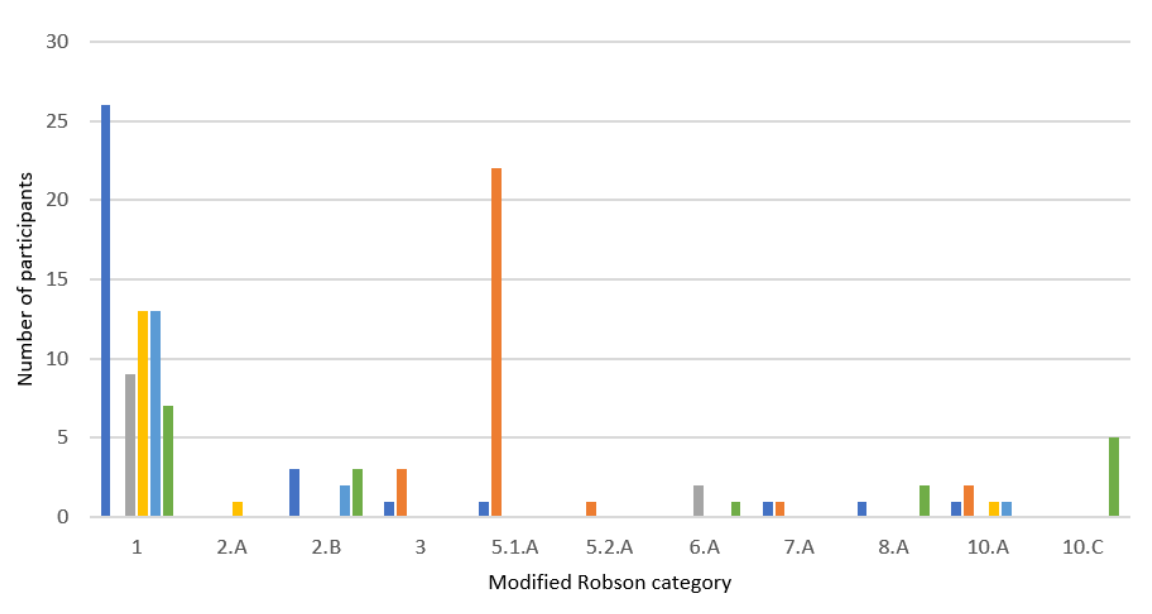
Figure 2. Distribution of CS indication according to modified Robson classification.